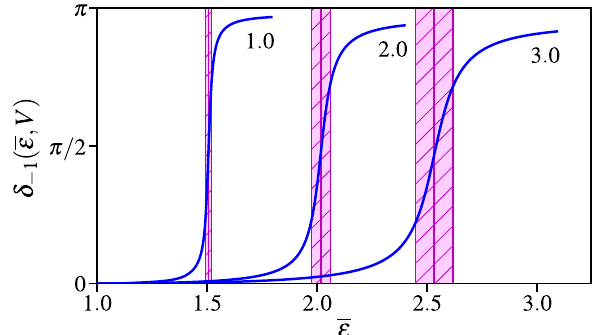
Fig. 4 Scattering phases near the boundary of the lower continuum for (cid:2) = − 1 and R = 1 / 20. The shaded areas show the positions and